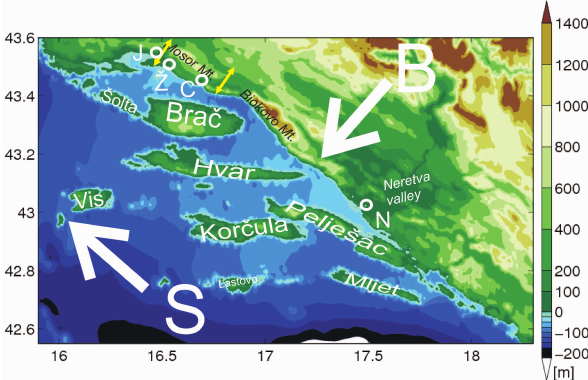
Fig. 1. Modeling domain and the actual topography. Positions of the two mountain passes (one northwest and the other south- east of Mosor Mountain) are indicated in yellow. The white cir- cles show river estuaries for Jadro (J), ˇZrnovnica (ˇZ), Cetina (C) and Nertva (N). Large white arrows indicate general Bora (B) and Sirocco (S) wind